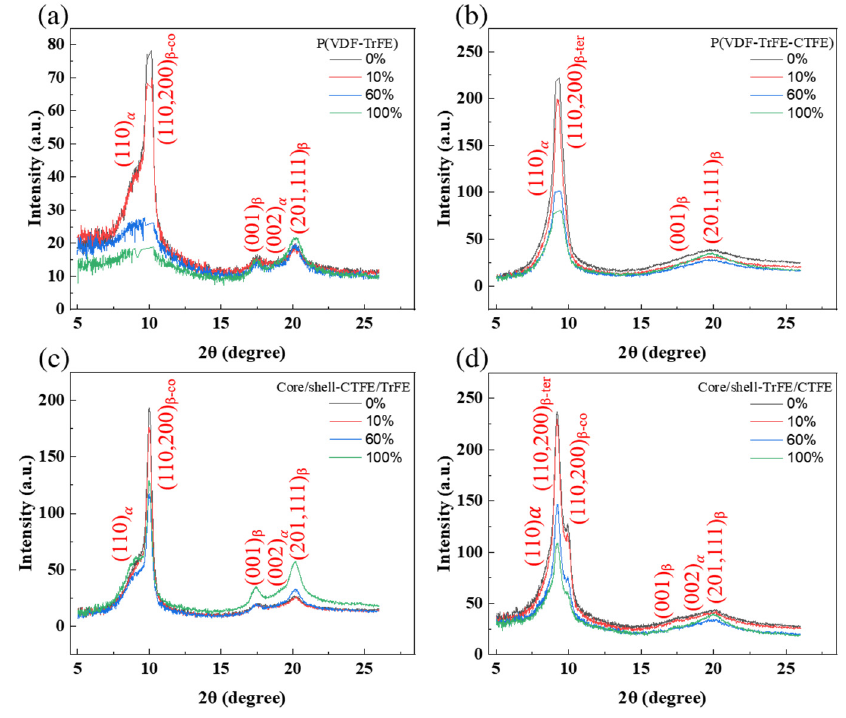
Figure 8. 1D WAXS intensity profiles and corresponding peak fitting in the ( a ) single P(VDF-TrFE), ( b ) single P(VDF-TrFE-CTFE), ( c ) core/shell-CTFE/TrFE, and ( d ) core/shell-TrFE/CTFE in CD.